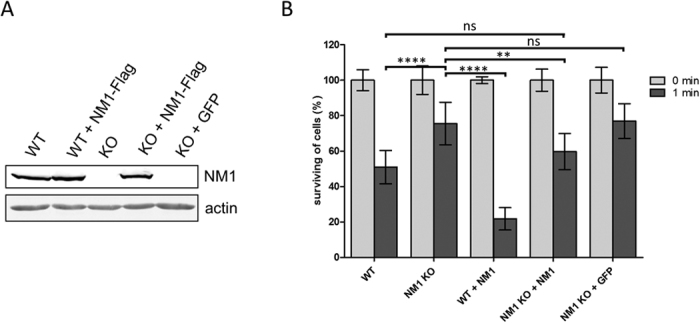
Knock-out of NM1 causes increased resistance to hypotonic conditions.(A) WT and NM1 KO mice were used for preparation of mouse skin fibroblasts. By exogenous expression of NM1-Flag in WT and NM1 KO cell lines, WT+NM1 and NM1 KO+NM1, respectively were prepared by lentivirus transduction. NM1 KO+GFP was used as a negative control (B). All cell lines were subjected to hypotonic conditions for 1 min followed by 2 hours of recovery under normal growth conditions. NM1 KO fibroblasts show significantly higher ability to resist hypotonic conditions than WT cells. Moreover, WT fibroblasts expressing extra NM1-Flag have lower ability to survive than WT cells. NM1 KO fibroblasts expressing NM1-Flag show similar survival rate as WT, which correlates with the amount of NM1 expressed by both cell lines. The KO-GFP cell line was used as a negative control of the lentivirus transduction effect on hypotonic stress survival. All measurements were done in triplicates. Values are shown as mean ± S.D and statistical significance is presented as ns p > 0.05, **p < 0.01, ****p < 0.0001, respectively.